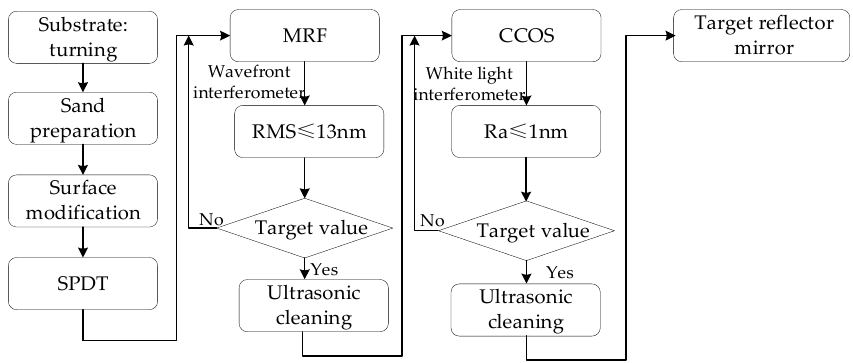
Figure 16. Road map of combined processing technology for Ni–P modified layer.